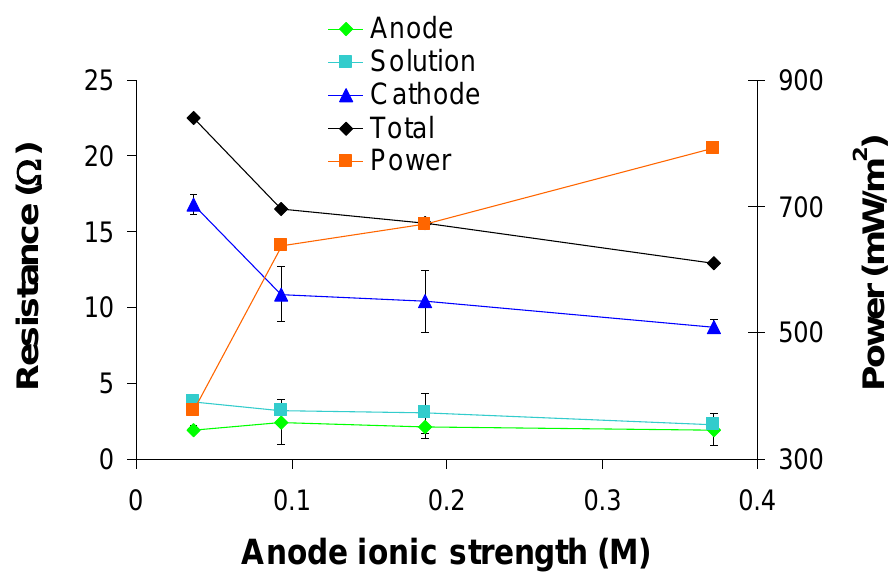
Figure 8 . ECM analysis results for EIS data while varying anode fluid